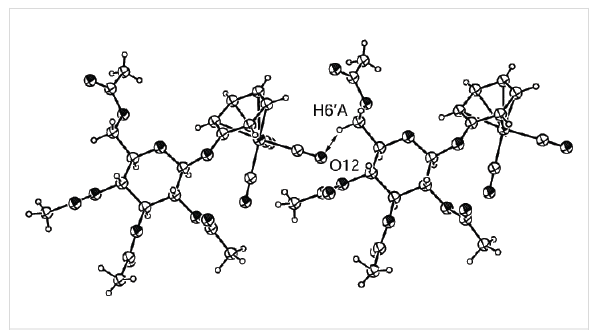
Figure 4: ORTEP-plot of the asymmetrical unit showing two mole- cules of compound 2c and 30% probability ellipsoids; the arrows show the nonclassical H-bonds between O12 and